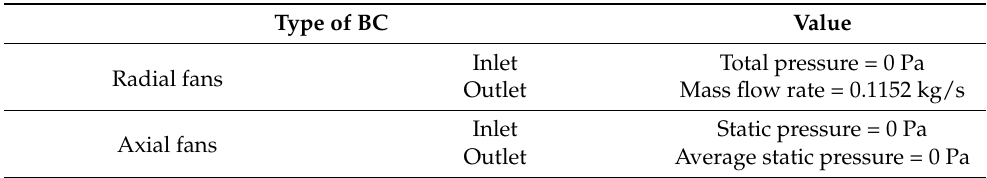
Table 1. Boundary conditions in CFD simulations for the inlet and outlet of the computational models; rotational speed in case of axial fans is varied between 900 rpm and 1700 rpm.